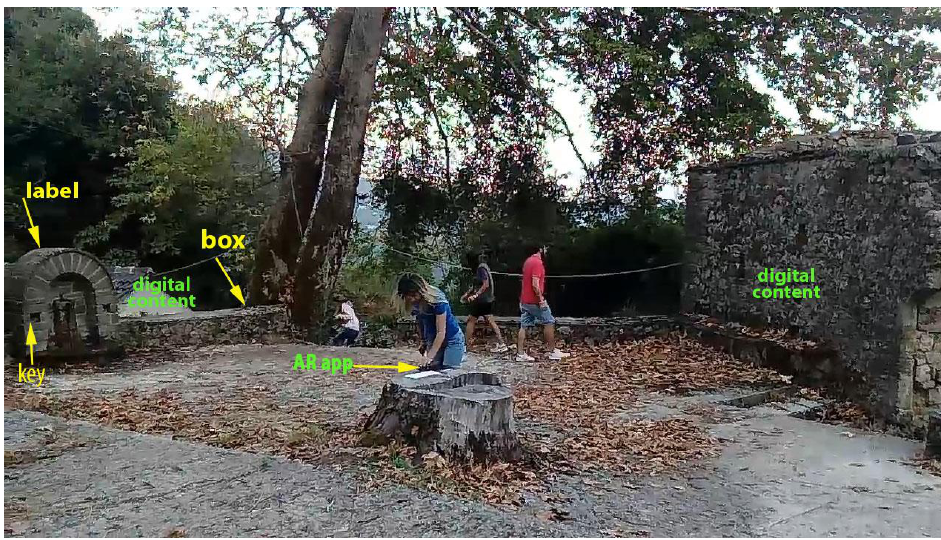
Figure 5. Location of the hidden objects.